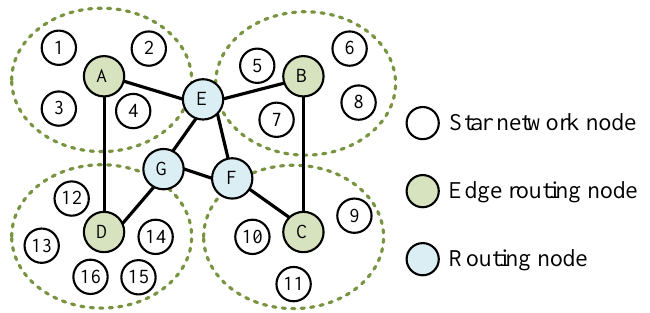
Figure 1. Schematic illustration of two-layered IWSNs. The number in figure denotes the node